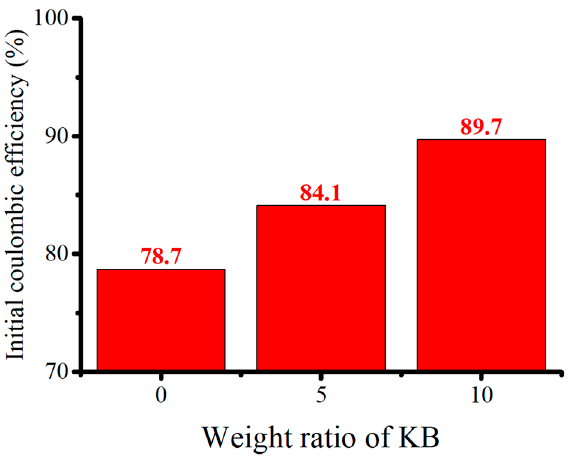
Figure 12. The relation between initial coulombic efficiency and mass ratio of Ketjen Black in the pyrolytic silicon-based electrode.